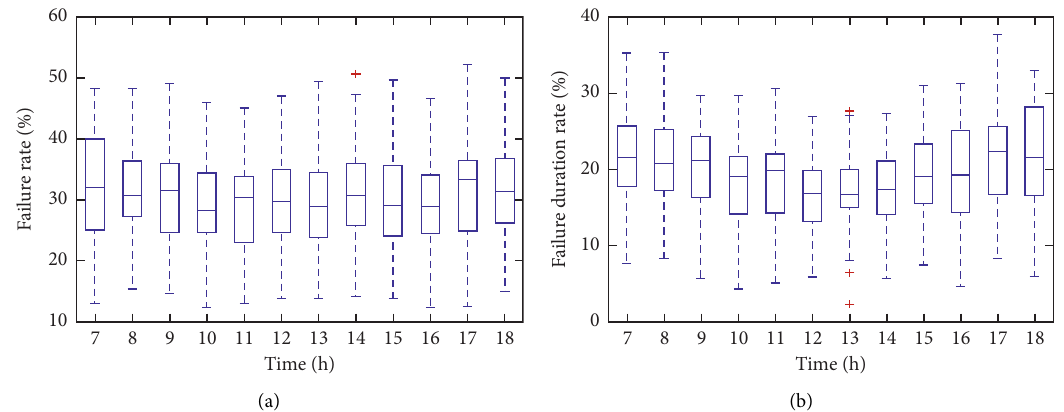
Figure 2: The time-varying characteristics of no.1 bus stop failure.